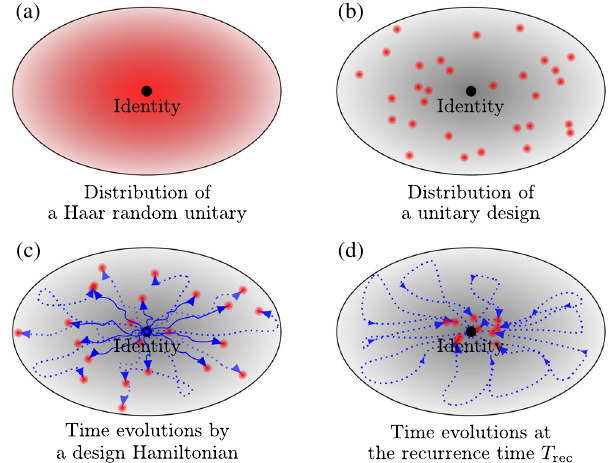
FIG. 3. Schematic figures illustrating the distributions of random unitaries in a whole unitary group. For the visualization, the unitary group is represented by an ellipse and each red dot corresponds to a unitary operator. Panel (a) illustrates a Haar random unitary, which is uniformly and continuously distributed over the whole unitary group. For unitary designs, the distribution is not necessarily continuous and is often defined on a finite support, which is depicted in (b). Panel (c) provides an intuitive picture of time-evolution operators generated by a design Hamiltonian, starting from the identity. As time passes, a design Hamiltonian generates random unitary distributed over the whole unitary. The time evolution is illustrated by a trajectory in the panel. When the design Hamiltonian is defined on a finite ensemble of Hamiltonians, there exists a time T , where all rec time evolution operators are in the neighborhood of the identity, due to the Poincaré recurrence theorem as depicted in